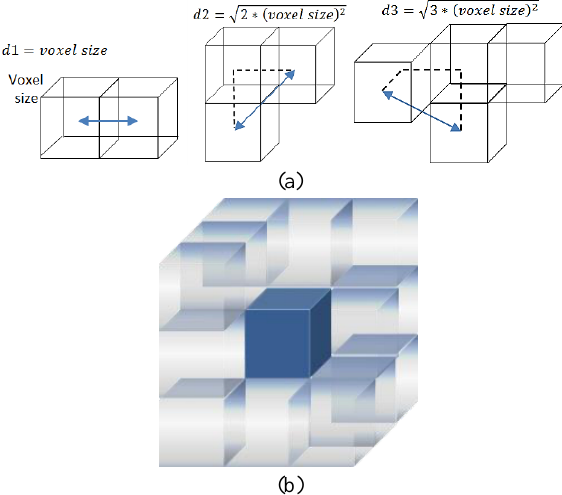
Figure 20. The methodology of gap detection